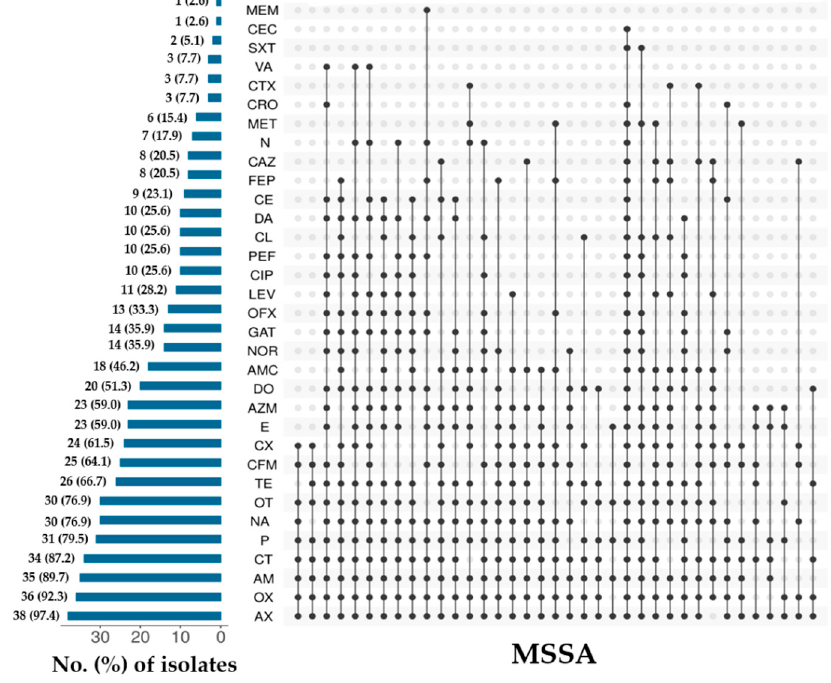
Figure 4. Individual antimicrobial resistance pattern of methicillin-susceptible S. aureus (MSSA) isolated from frozen chicken meat.